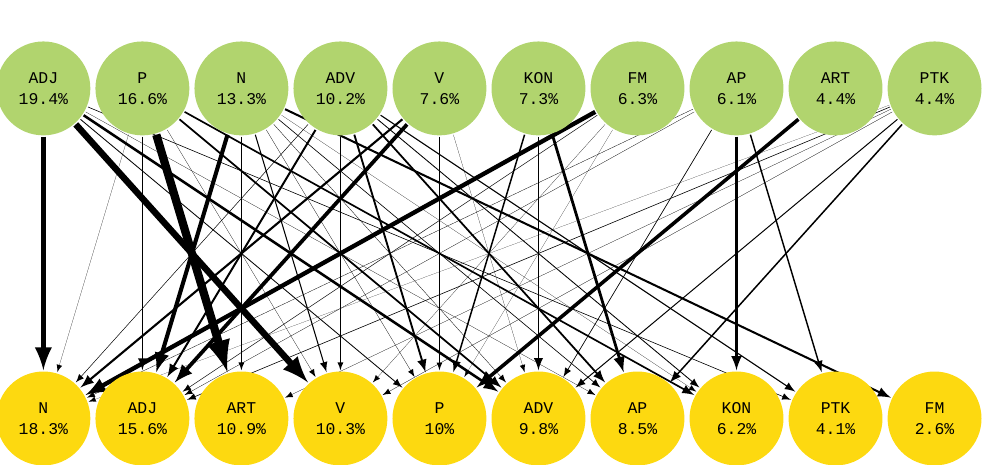
Figure 7: Percentage of POS tagging errors using sSTTS for all taggers on